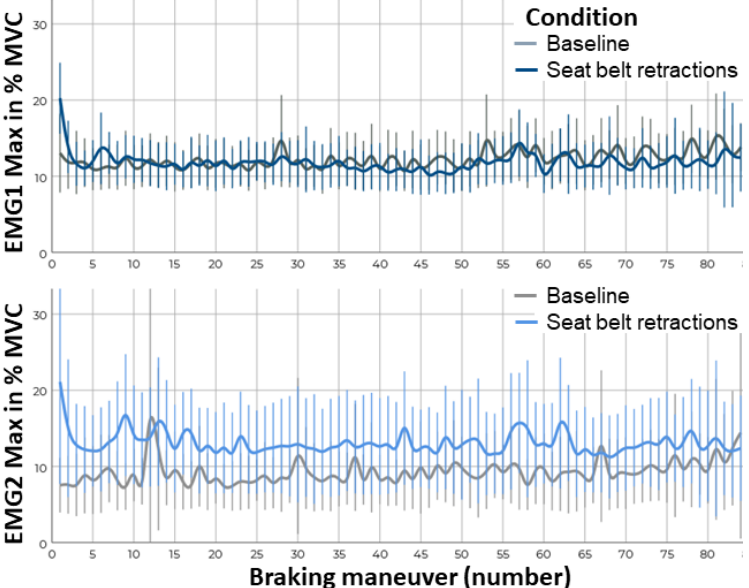
Figure 11. Course of the maximum neck muscle tension over the brakings encountered per experi- mental condition (upper part: EMG1; lower part: EMG2). Error bars display 95% confidence inter- vals.